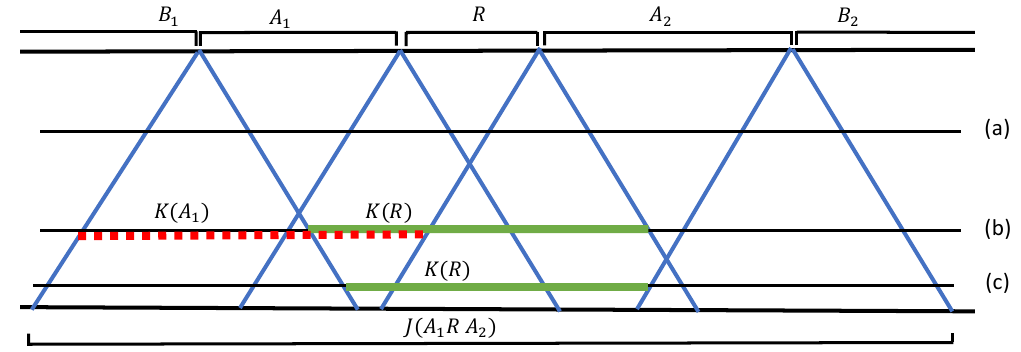
Figure 5 . Different situations for two intervals. Different horizontal lines correspond to t = 0 slices for (a) t < | R | / 2 ; (b) t > | l 1 | / 2 ; (c) t > | l 2 | / 2 . Here we take | R | < | A 1 | and thus l 1 = | A 1 | and l 2 = | A 2 |